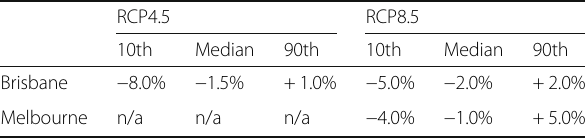
Table 1 Climate projections for extreme wind speed to 2090 under two CO 2 emission scenarios RCP4.5